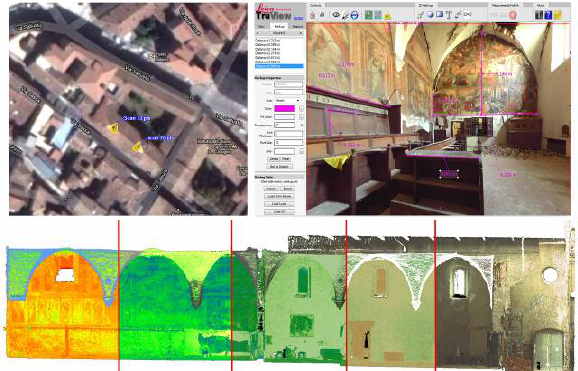
Figure 8. TruView platform built using Cyclone software (above). Composition of reflectance maps (below) (software: Cyclone).